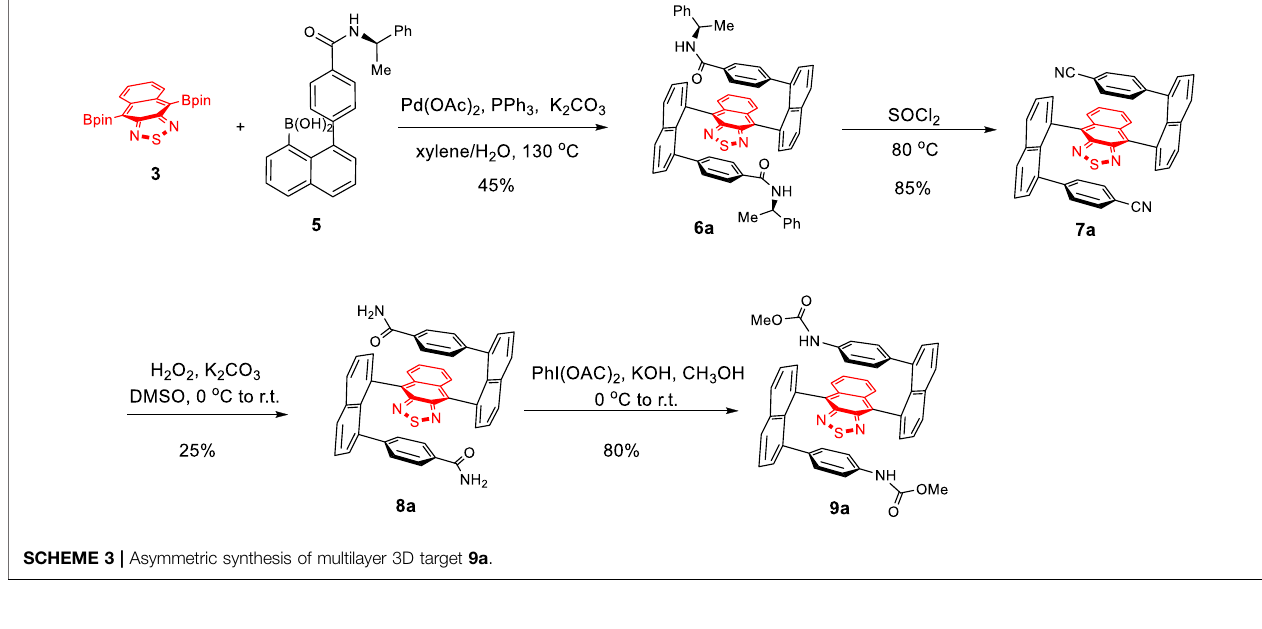
( Figure 2A ). The enantiomers ’ packing in a single X-ray unit cell represents an interesting arrangement in which the